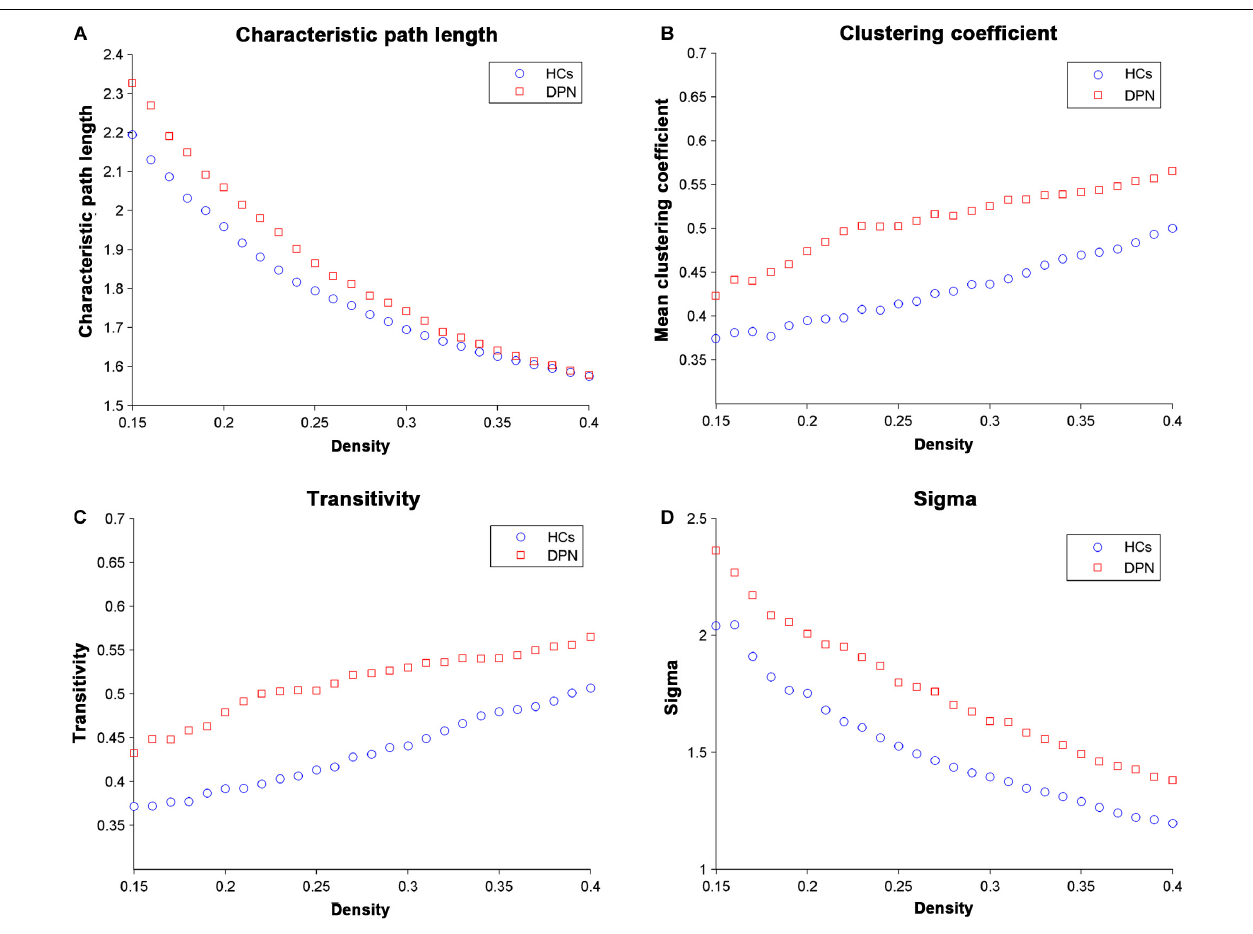
sigma ( Figure 3 ), lambda, gamma ( Supplementary Figure S1